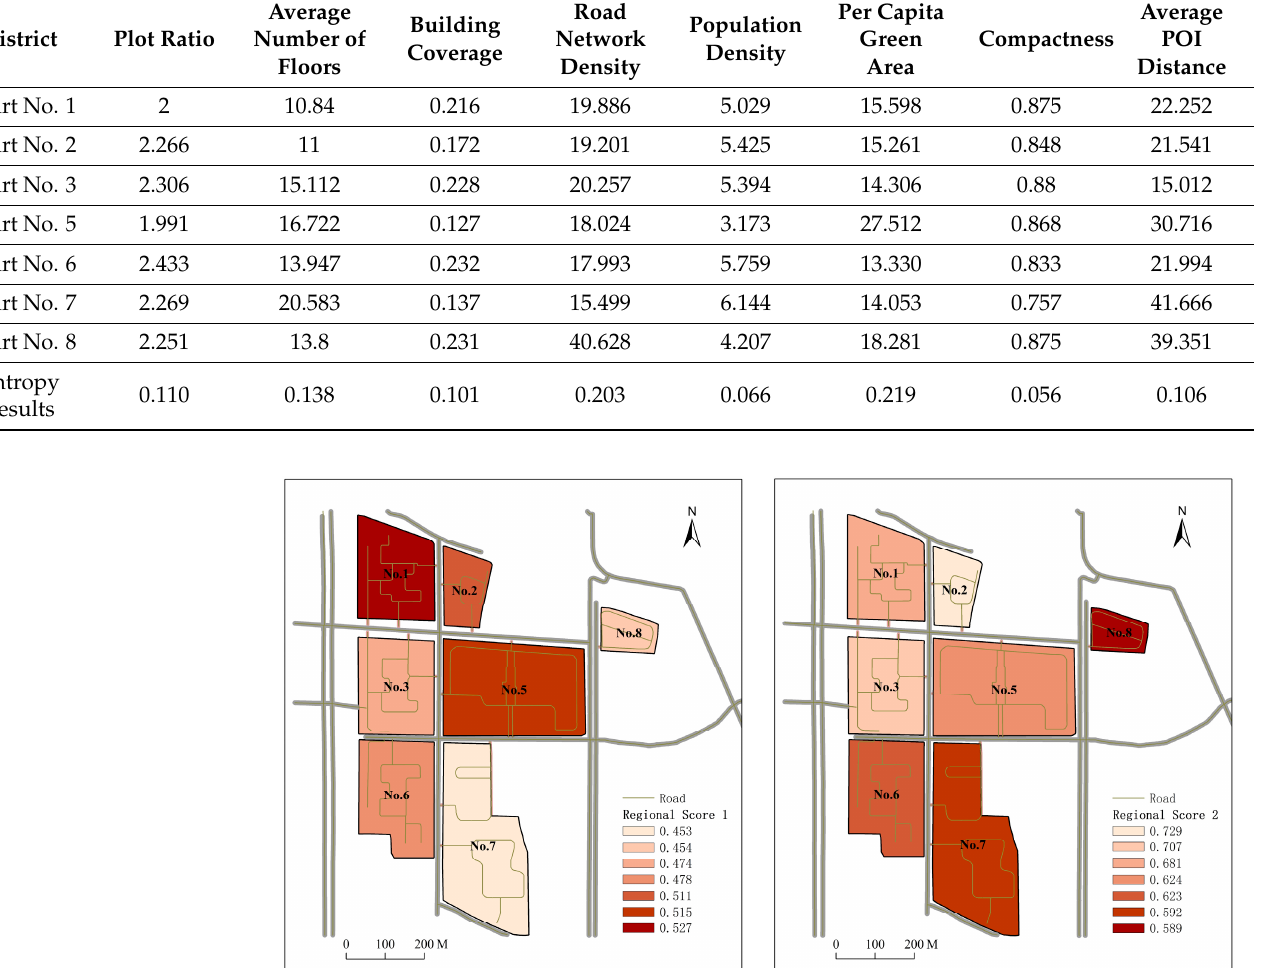
Table 2. The indicator calculation results and weight of each courtyard.